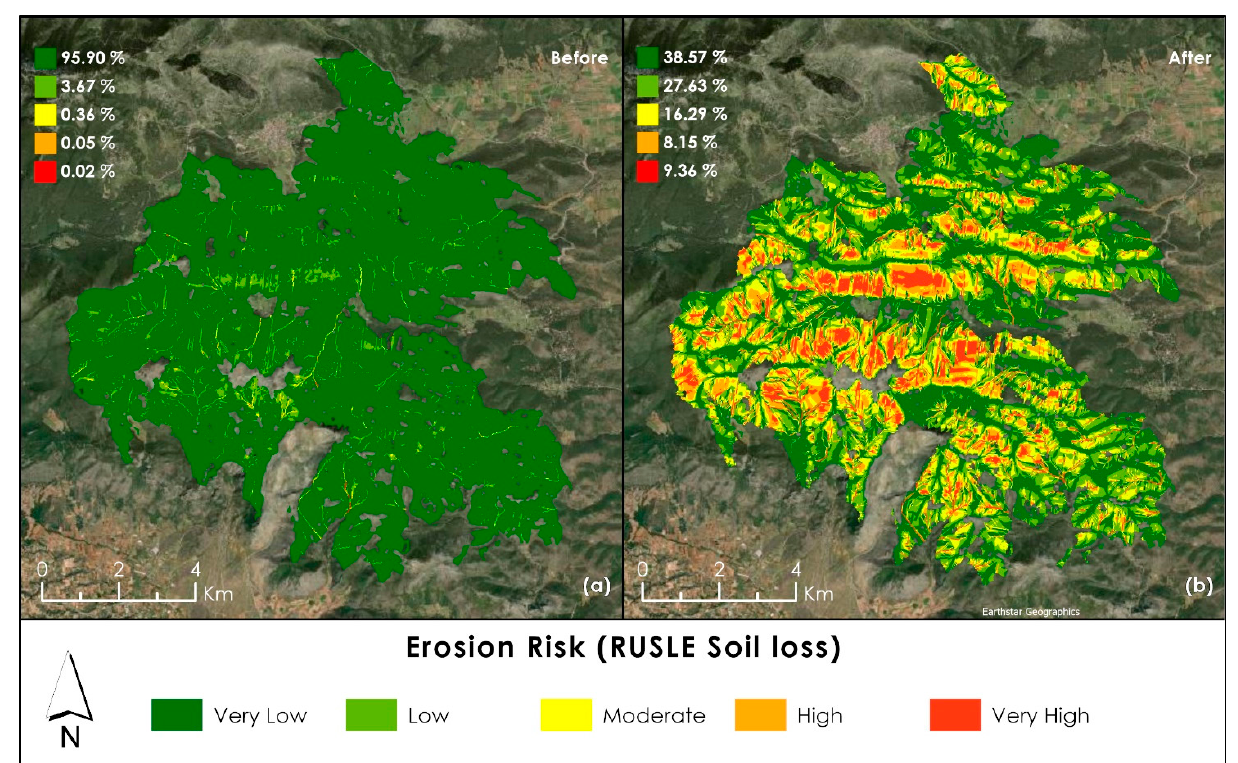
Figure 7. Erosion risk according to RUSLE soil loss for Lavreotiki burned area: ( a ) before the fire; ( b ) after the fire. The erosion risk as classified is presented including the percentage of the burned area total of each area per class.